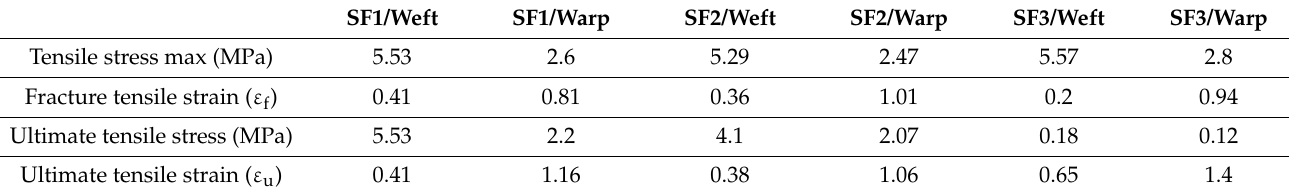
Table 5. Tensile stress/strain fracture/ultimate of spacer fabrics at 23 ◦ C, 7 days.